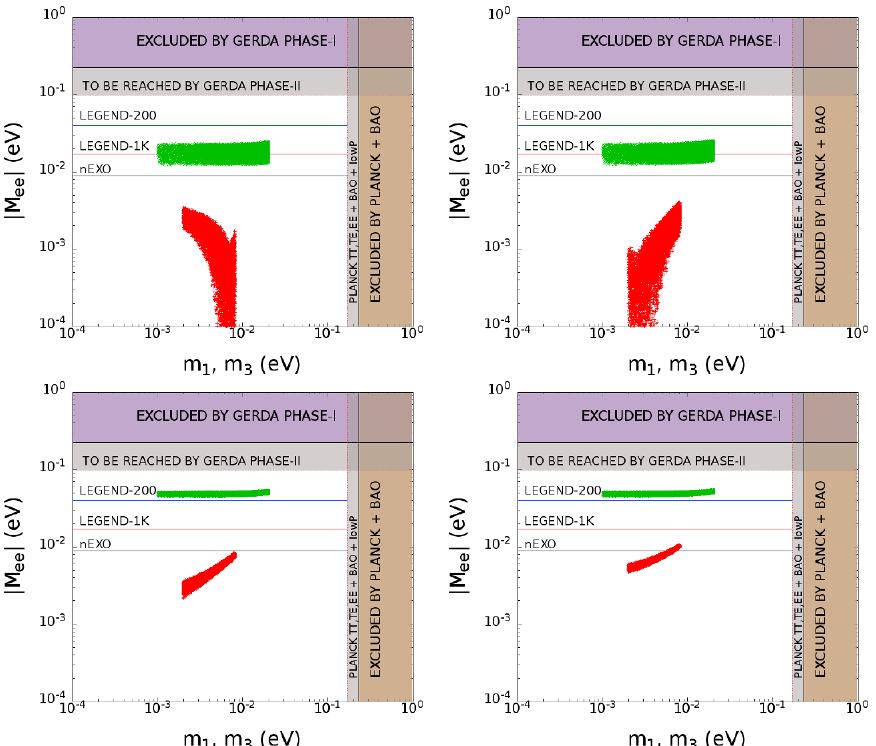
Figure 5 . Plot of j M ee j vs. the lightest neutrino mass: the top two (cid:12)gures represent Case A: (cid:11) = (cid:25) , (cid:12) = 0 (left) and Case B: (cid:11) = (cid:25) , (cid:12) = (cid:25) (right) while the (cid:12)gures in the lower panel represent Case C: (cid:11) = 0, (cid:12) = 0 (left) and Case D: (cid:11) = 0, (cid:12) = (cid:25)